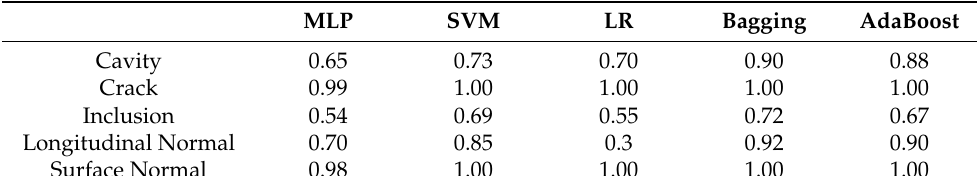
Table 2. The accuracy of different algorithm on the identification of different defect types of aero- engine blade.